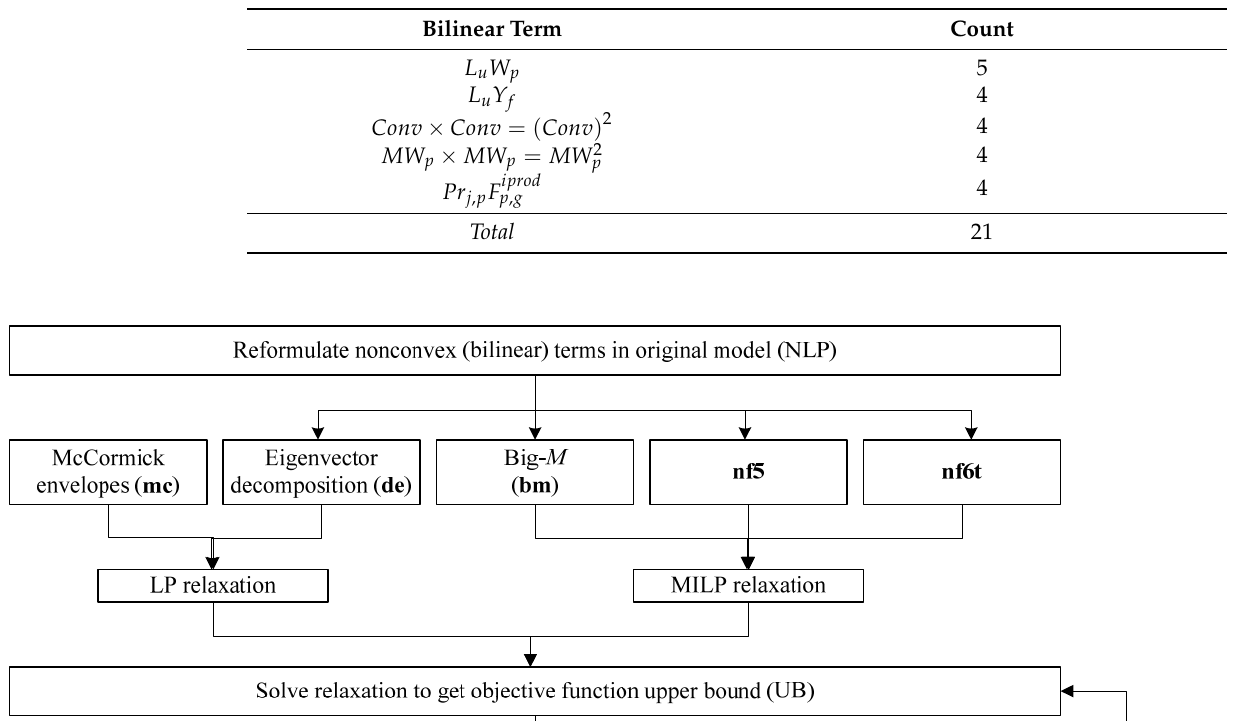
Table 3. Bilinear terms in the refinery planning NLP model.